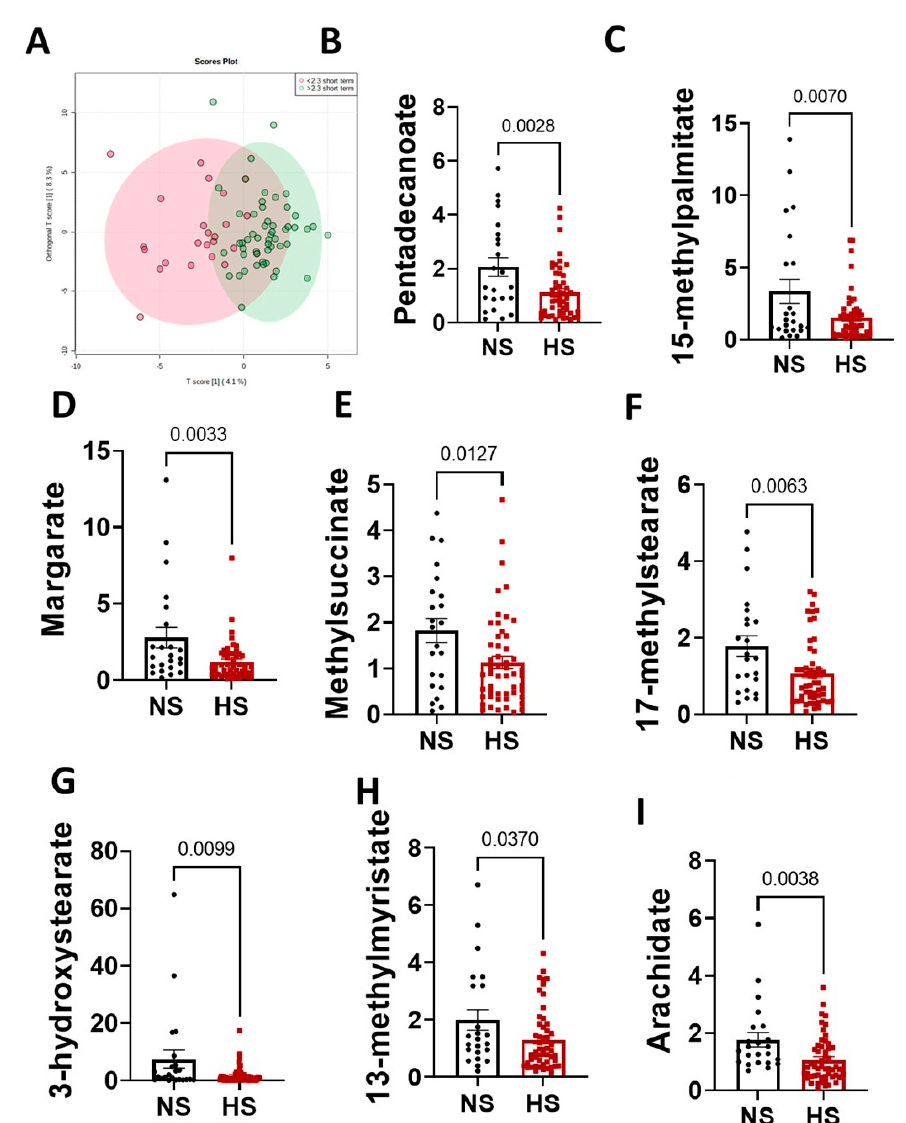
(Figure 4E), 17-methylstearate (Figure 4F), 3-hydroxysterate (Figure 4G), 13-methymyristate (Figure 4H) and arachidate (Figure 4I) were significantly decreased in feces from partici- pants in the high salt group compared to those consuming a normal salt diet.